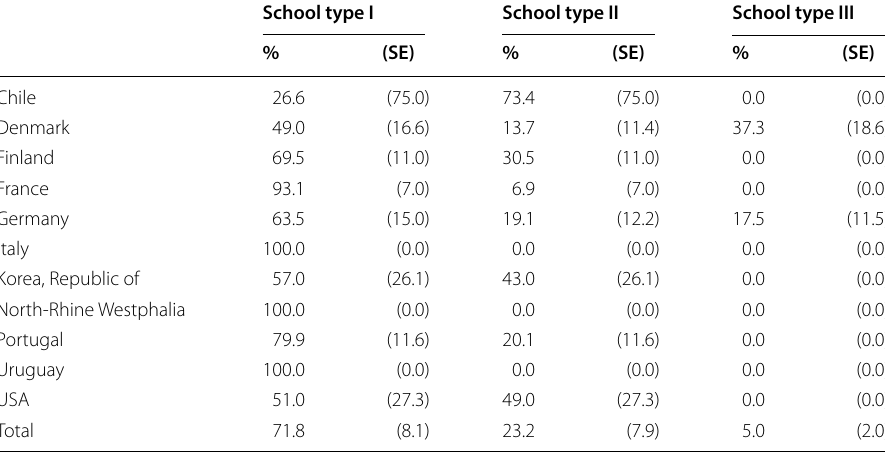
Table 6 Distribution of resilient school types in those participating countries and benchmark participants of IEA‑ICILS 2018 where organizationally resilient schools could be